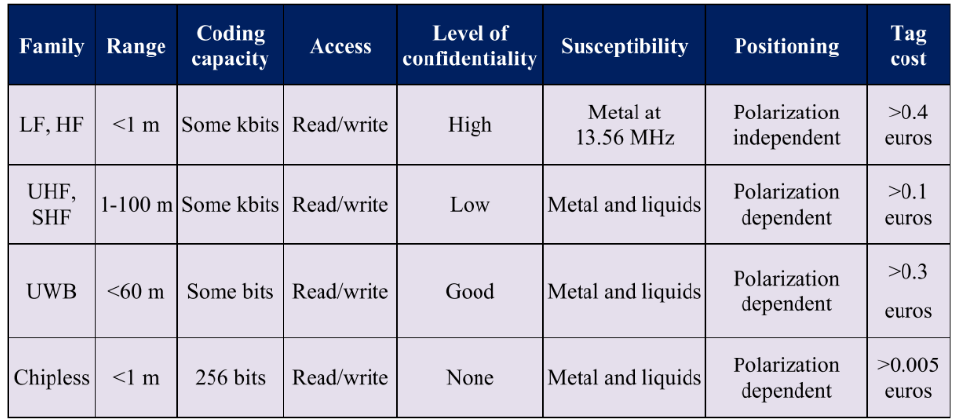
Figure 28. Classification of RFID technologies by frequency (Reprinted with permission from ref. [133]. Copyright 2016